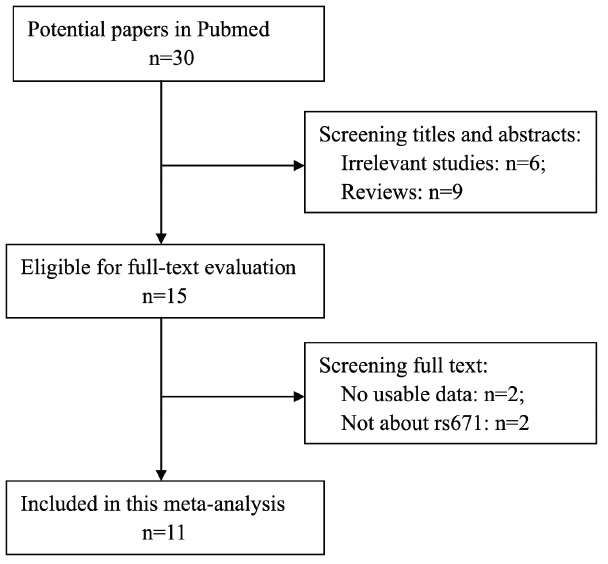
Figure 1. Flowchart of the study selection.